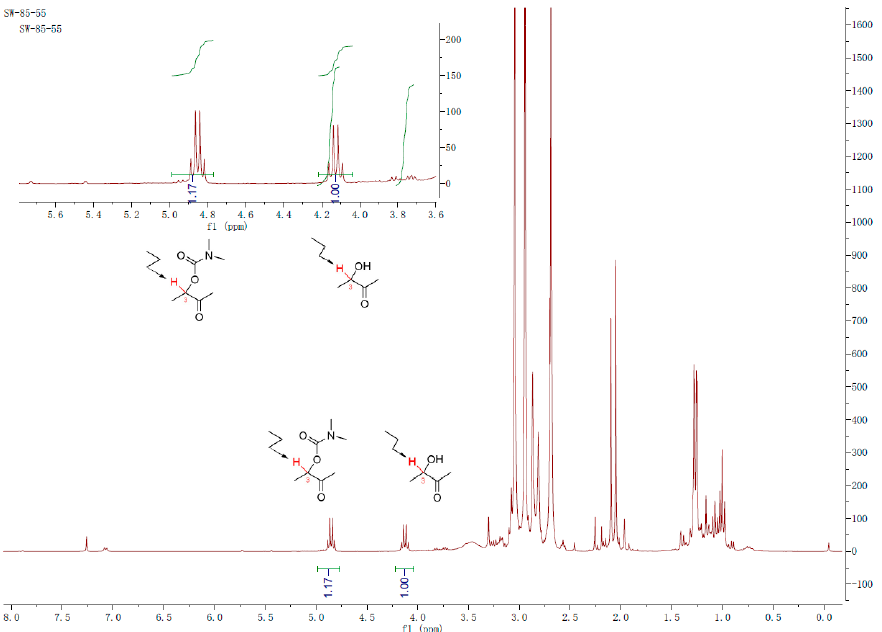
Figure 3. 1 H NMR spectrum for the crude product from reaction of α -hydroxyl ketones with N , N -dimethylcarbamoyl chloride. Scheme 4. Synthesis of 3- O